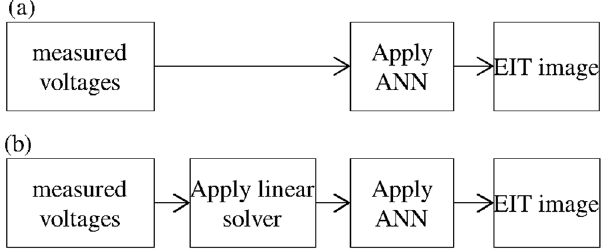
Figure 1. EIT Comparison between ( a ) existing reconstruction methods using an ANN and ( b ) the proposed